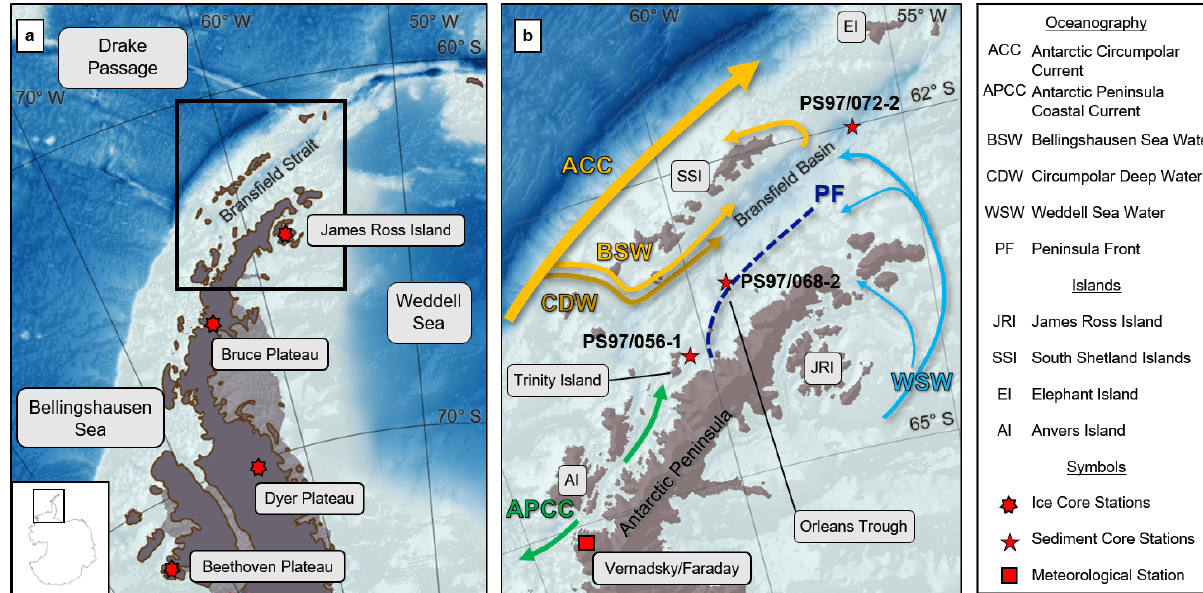
Figure 1. (a) Overview map of the Antarctic Peninsula with the position of the ice cores from Dyer Plateau, Beethoven Plateau, James Ross Island (Abram et al., 2010) and Bruce Plateau (Goodwin et al., 2016) as well as bathymetric features in the Bellingshausen Sea, the Weddell Sea and the Drake Passage. (b) Oceanographic setting in the study area (modified after Hofmann et al., 1996; Moffat and Meredith, 2018; Sangrà et al., 2011), sediment and ice core sites, and geographic locations mentioned in the text. Maps were generated with QGIS 3.0 (2018), and the bathymetry was taken from GEBCO_14 from 2015.